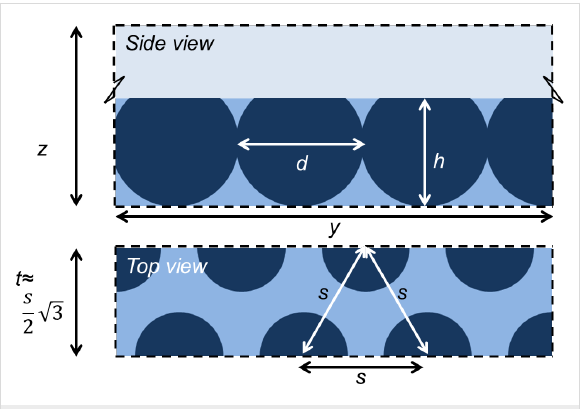
Figure 6: Schematic side view ( z , y )-plane and top view ( x , y )-plane of an inverse opal with two rows of n = 3.5 cavities in a staggered packing (3.5 cavity volumes are in the system, four cavity positions are required). The distance between two ( m = 2) rows is t . For a hexago- nal packing the two rows are displaced with respect to each other by a value , where s is the distance between the cavities. On a lattice t must be an integer. Reflecting boundaries are applied in all